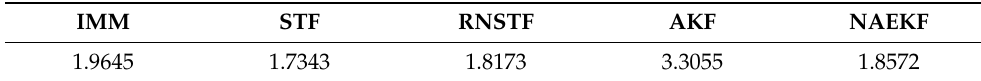
Figure 11. σ -Boundary of acceleration estimation errors. ( a ) σ -Boundary of a x ; ( b ) σ -Boundary of a y ; ( c ) σ -Boundary of a z . Table 8. Computing time